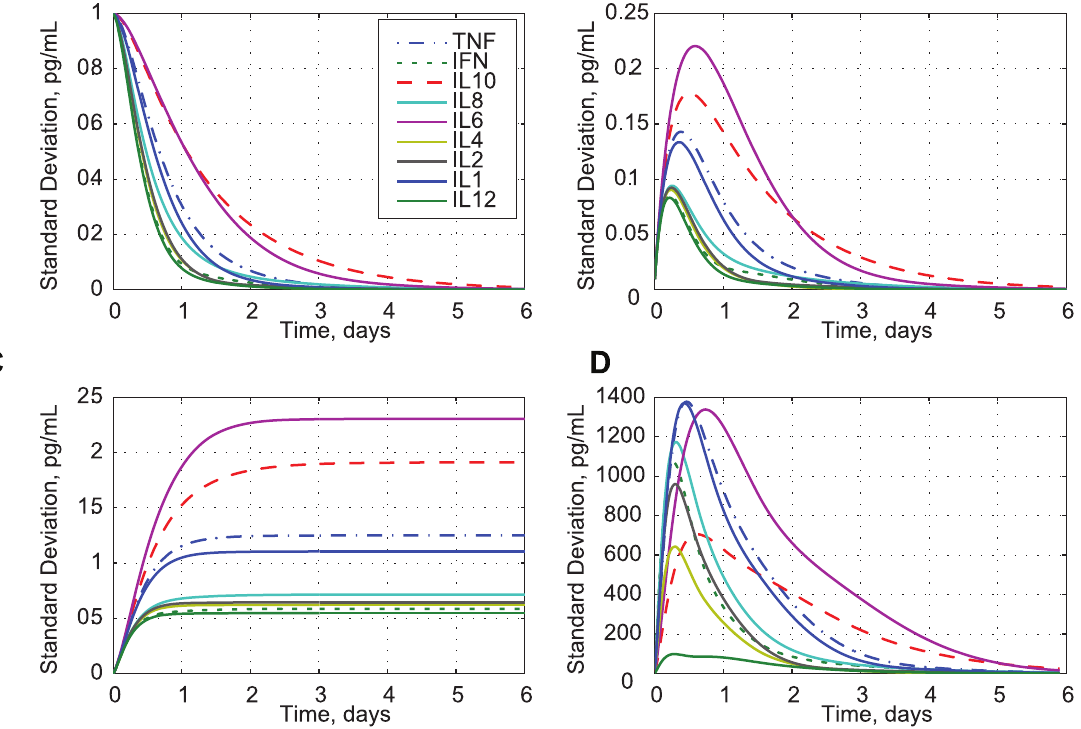
Figure 13. Effects of uncertainty in initial conditions, random disturbances, and system parameter variations on cytokine standard deviations. A) Standard deviation with initial concentration uncertainty. B) Standard deviation with initial rate uncertainty. C) Standard deviation with process noise. D) Standard deviation with parameter variations.